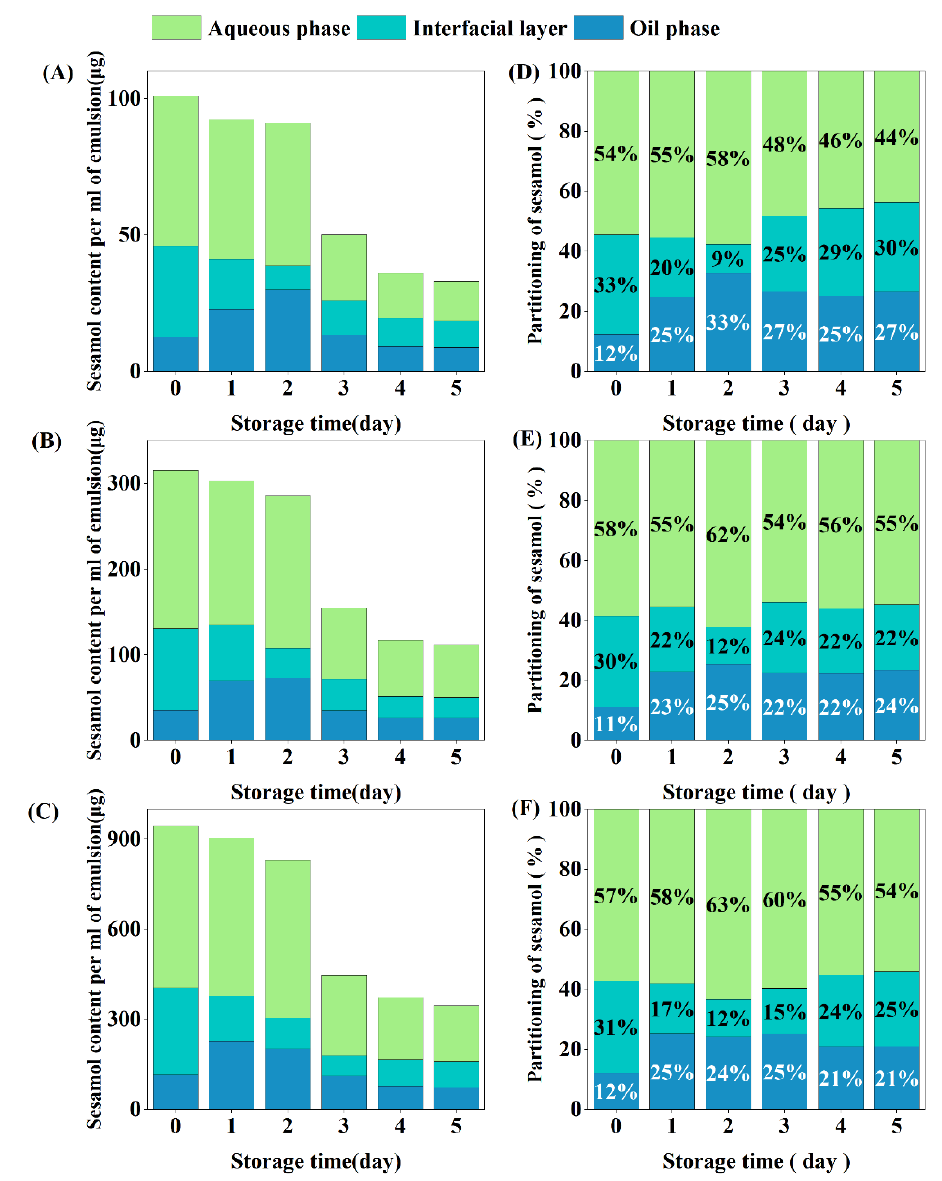
Figure 8. Interfacial partitioning of sesamol in emulsions. Content of sesamol in the aqueous phase, oil phase, and interfacial layer per ml of emulsion (( A ): 0.01% sesamol, ( B ): 0.03% sesamol, ( C ): 0.09% sesamol). Percentage partitioning of sesamol in the aqueous phase, oil phase and interfacial layer (( D ): 0.01% sesamol, ( E ): 0.03% sesamol, ( F ): 0.09% sesamol).